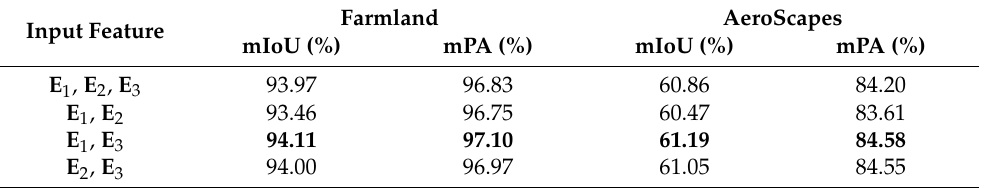
Table 1. Comparison of different feature combination inputs of the RCCT module.